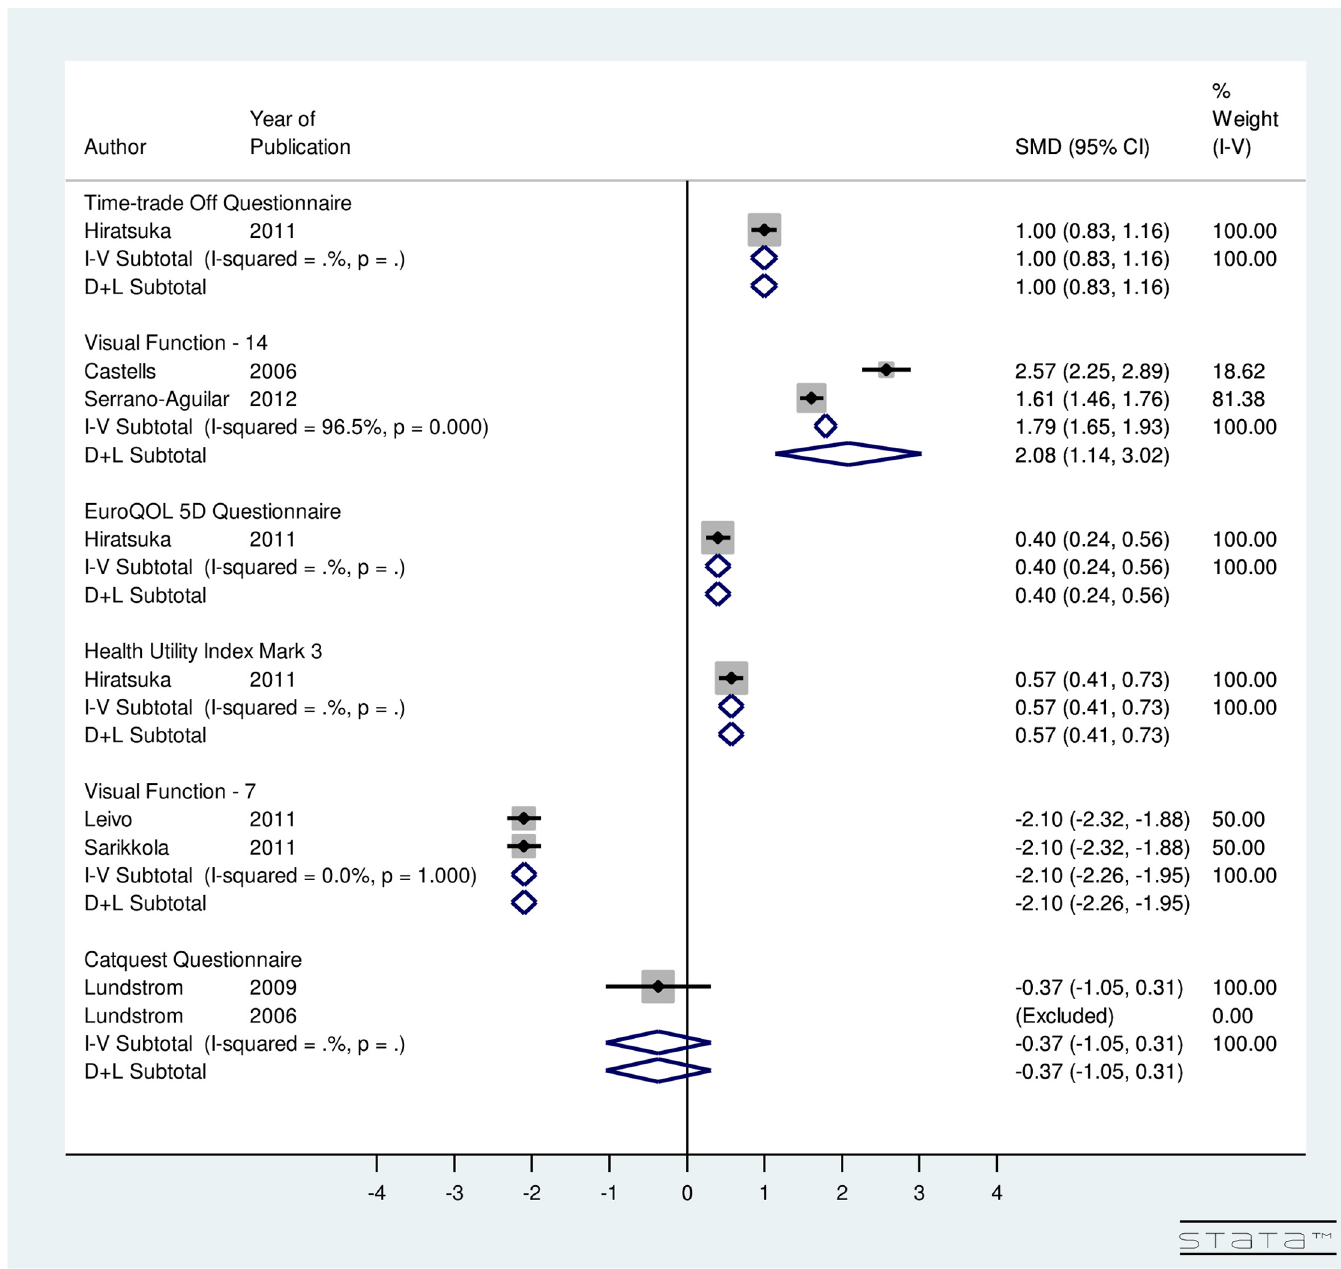
Fig 3. Forest Plot showing Improvement in Utility Due to Immediately Sequential Bilateral Cataract